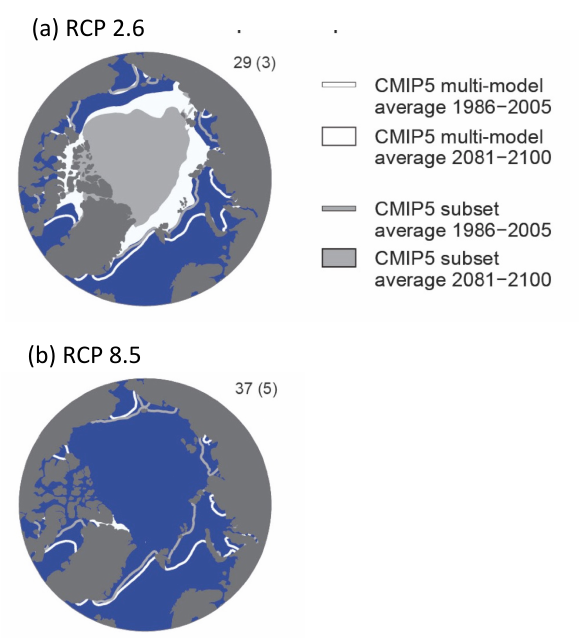
Figure 14. Modeling results of the future of the sea ice cover in the Arctic with (a) continued increase in greenhouse gases and (b) keeping the greenhouse gases at the same level as it is at present. (Courtesy of IPCC